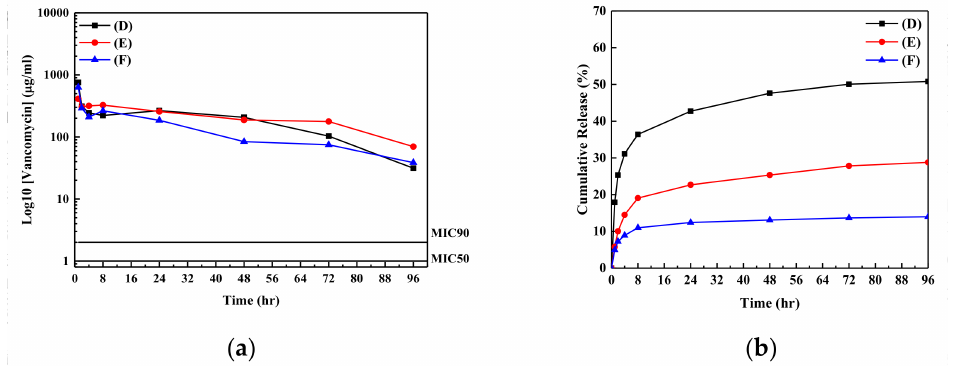
Figure 4. ( a ) Release profiles and ( b ) the cumulative amounts of vancomycin released from samples (D–F) into the bu ff er solution as a function of time.